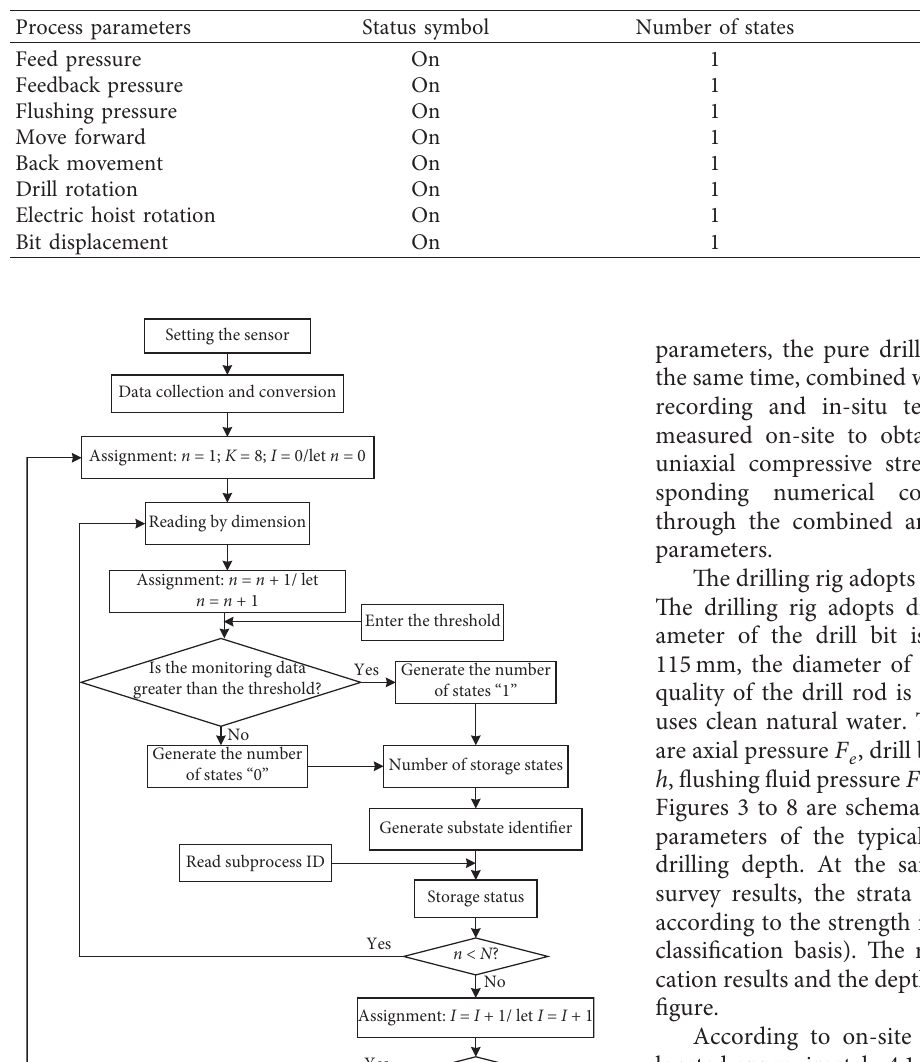
Table 6: Threshold value of each state of drilling subprocess.